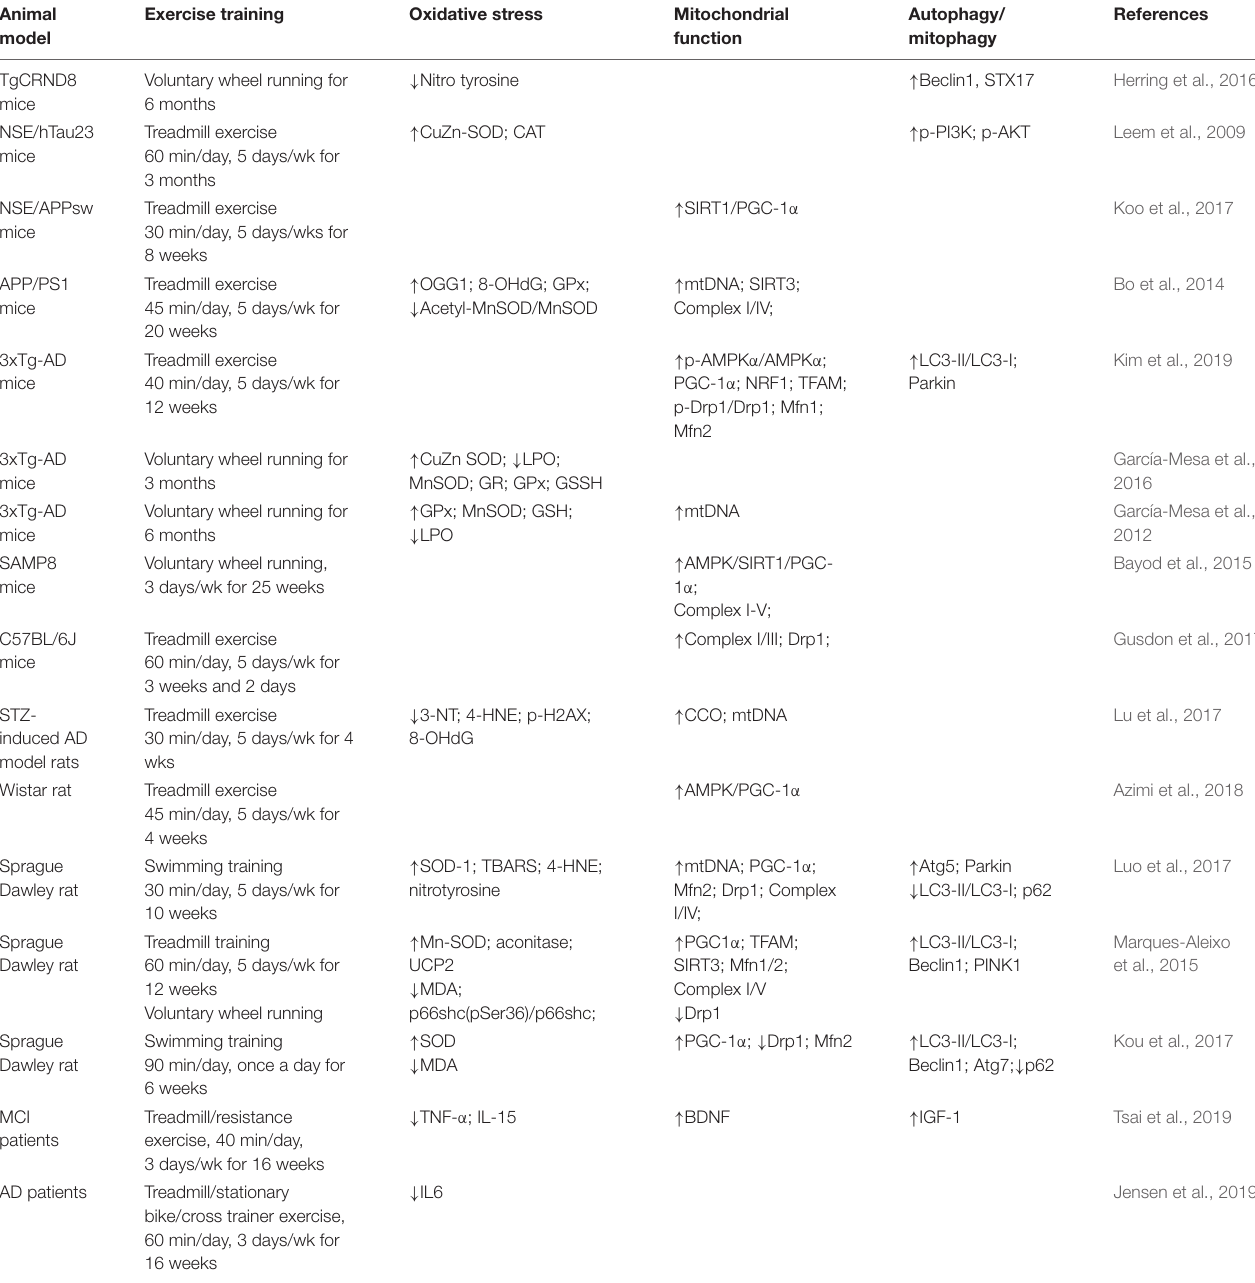
TABLE 1 | Effect of exercise on oxidative stress, mitochondrial function and autophagy/mitophagy proteins in AD. Animal